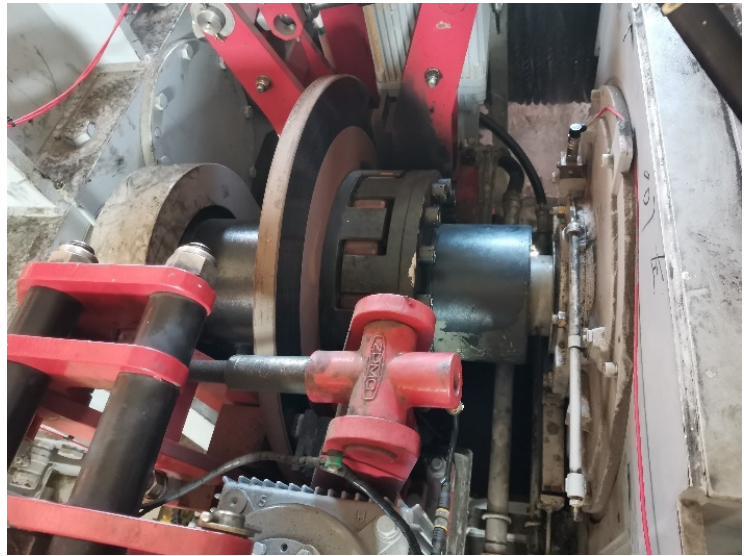
Figure 6. The mounted